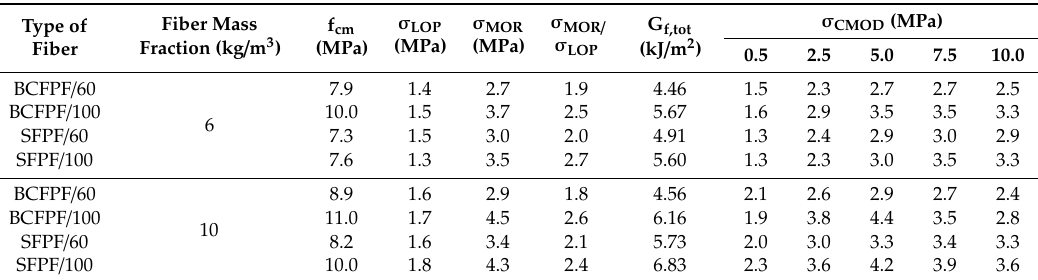
Table 6. Mechanical parameters of fiber-reinforced soil-cement with 400 / 1.2 matrix after 28 days of curing.